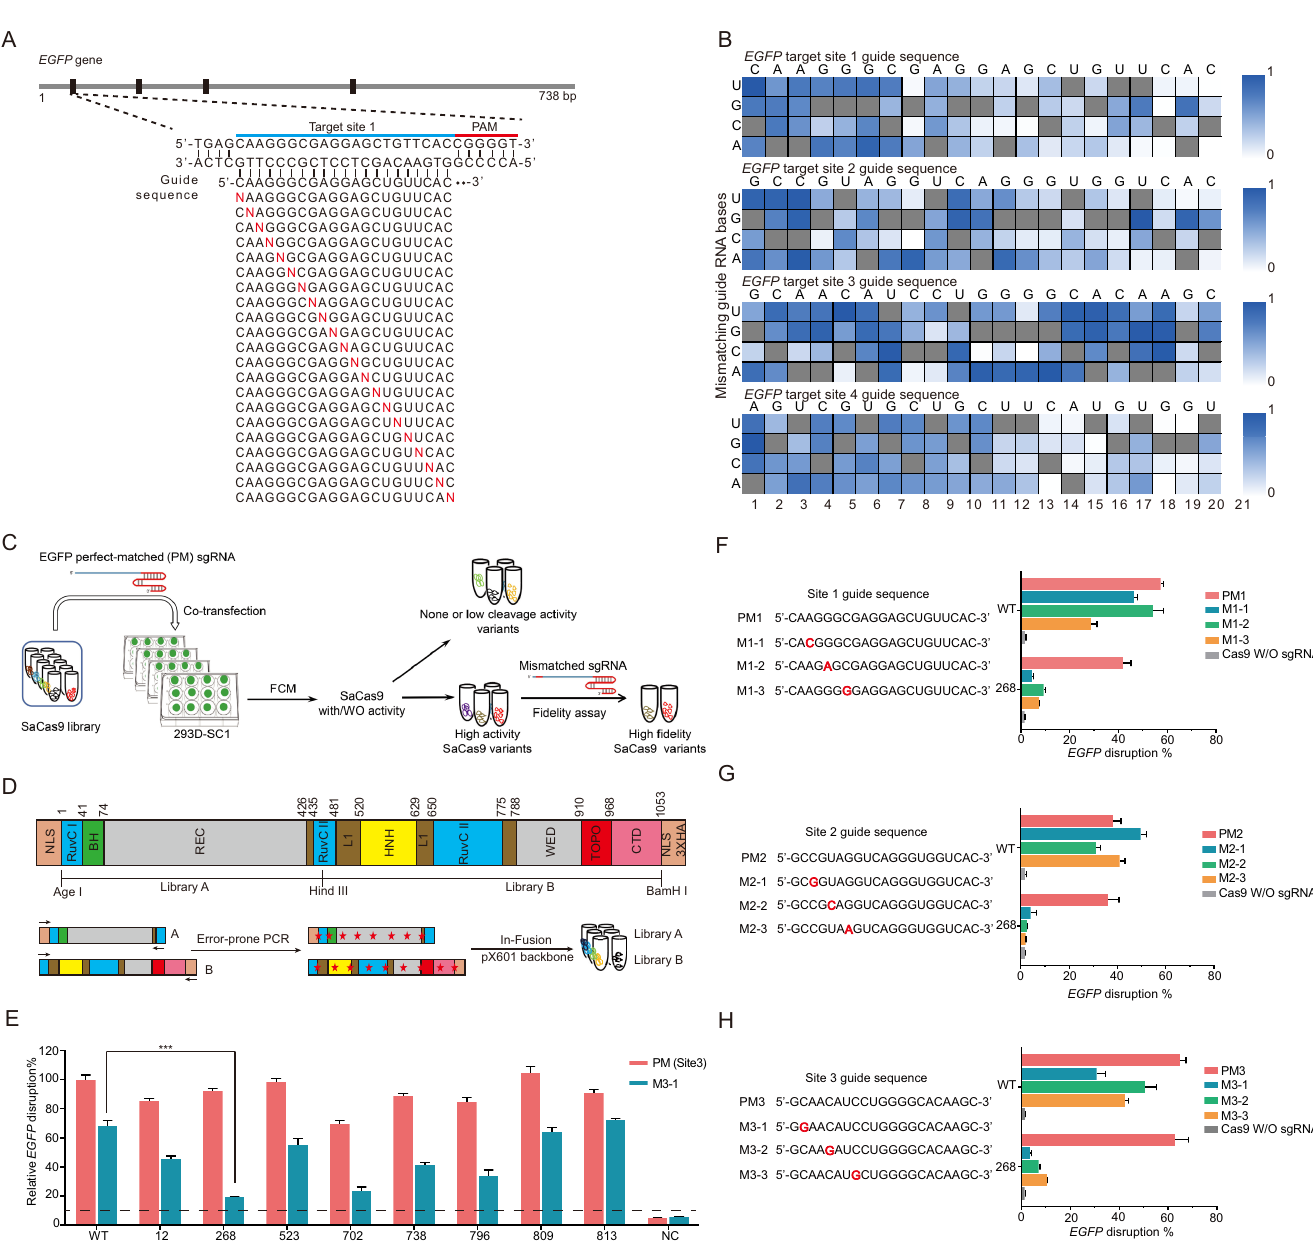
Fig 1. Library construction and screening of SaCas9-HF variants. (A) Schematic of the protocol for CRISPR-SaCas9-mediated gene editing of EGFP . (B) Heatmap represents the relative SaCas9 cleavage efficiency by 63 single-mutated and one perfect-matched sgRNA each for 4 EGFP target sites ( n = 3). Nonmutated guide sequence is shown above and highlighted in gray squares in the heatmap. Relative EGFP disruption efficiencies (increasing from white to blue) are normalized to the nonmutated guide sequence. The data underlying this figure can be found in S1 Data. (C) The schematic of constructing two mutational SaCas9 libraries by error-prone PCR with in-fusion methods. “ � ” represents the mutation. (D) The schematic strategy of screening SaCas9-HF variants. (E) Eight variants were investigated with perfect- matched sgRNA site 3 sgRNA and single-nt mismatched sgRNAs site 3 sgRNA. Relative disruption efficiencies are normalized to the perfect-matched guide sequence with WT SaCas9; error bars, SEM; n = 3. (F–H) Validation of enhanced fidelity of Mut268 variant. For each site, WT SaCas9 and variants were assessed by EGFP disruption assay with a perfect-matched sgRNA or single-nt mismatched sgRNAs. The data underlying this figure can be found in S2 Data; error bars, SEM; n = 3. 268, Mut268; EGFP , enhanced green fluorescence protein; FCM, flow cytometry; M, mismatched; M3-1, single-nt mismatched sgRNA site 3; PM, perfect-matched; PM3, perfect-matched sgRNA site 3; SaCas9, Staphylococcus aureus Cas9; sgRNA, single-guide RNA; single-nt, single nucleotide; W/O, without; WT, wild-type.